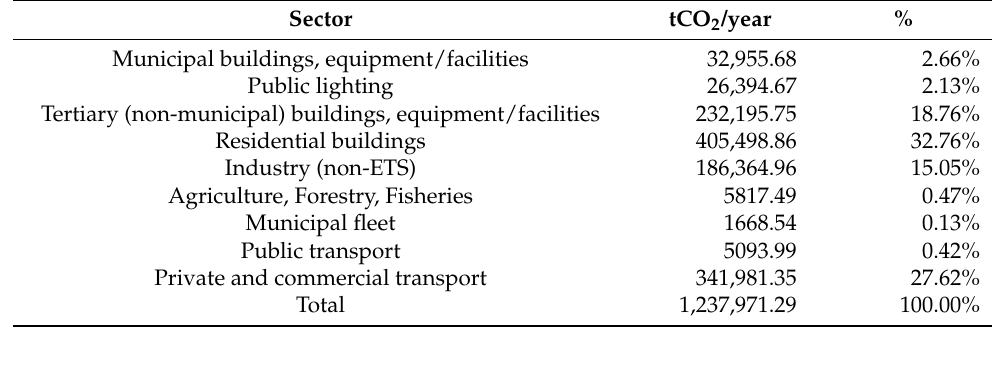
Table 5. CO 2 emissions by sector.